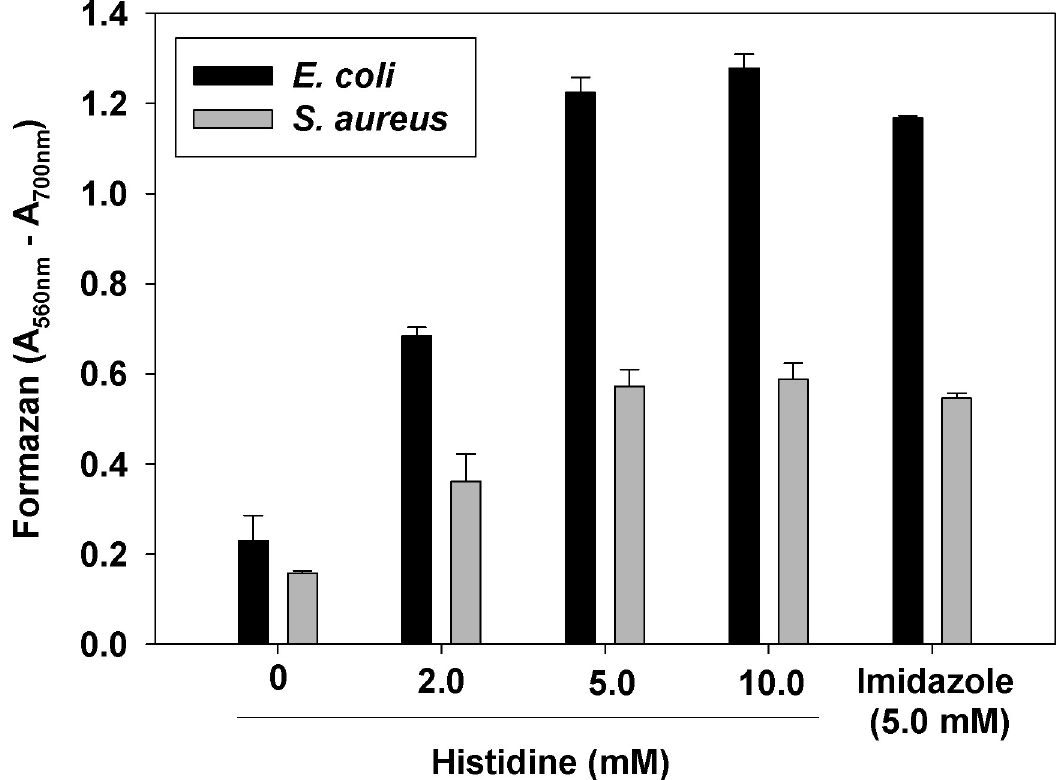
Fig 3. Concentration-dependence of the effect of histidine on MTT reduction. Histidine or imidazole were added to E . coli and S . aureus cell suspensions with density of OD 600nm = 0.1. In all experiments the medium was PBS + glucose. After 10 min of incubation with histidine or imidazole, the MTT assay was performed. Experiments were repeated three times, each sample in triplicate. Mean ± S.D. is